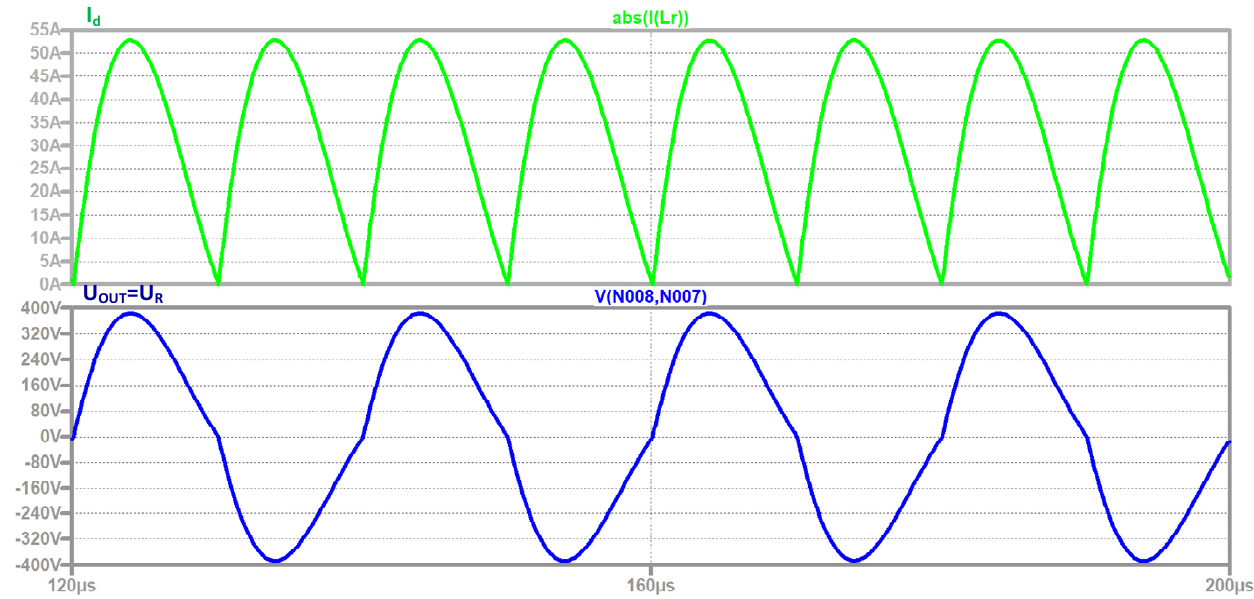
Figure 6. Time diagram of the input current—I d and output voltage—u OUT .